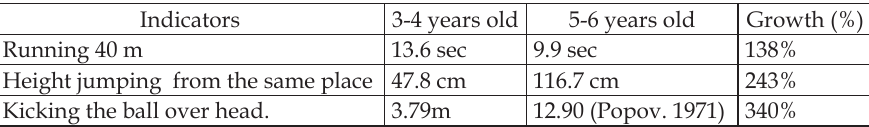
Table 1. Comparative format to the average of search results from 3 to 6 years old.